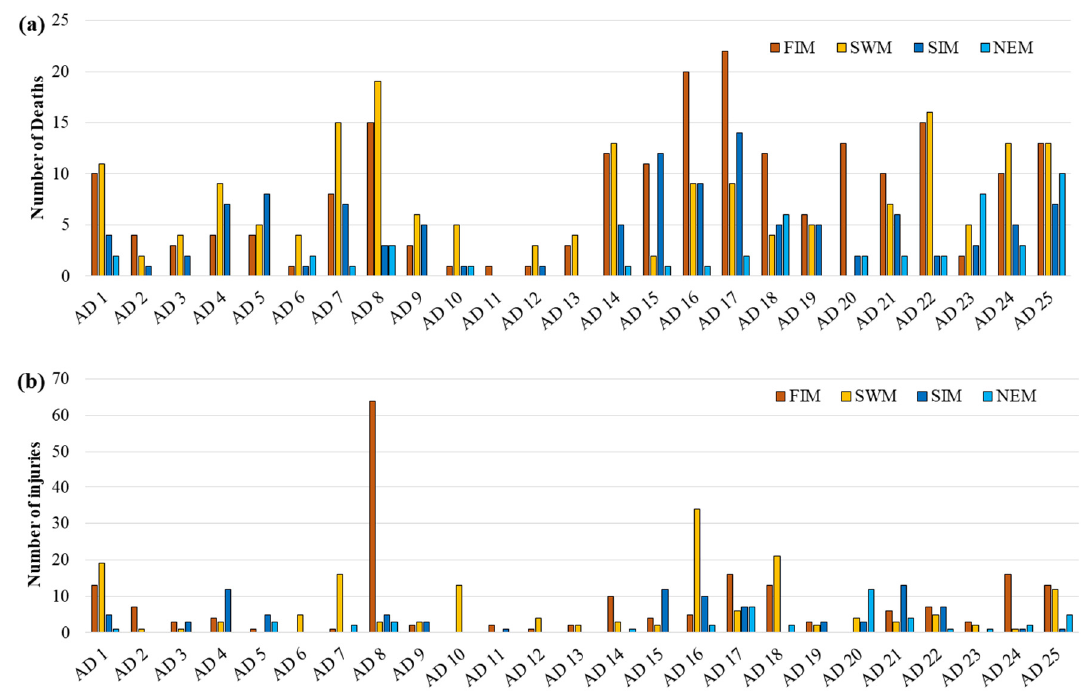
Figure 2. Lightning accidents in Sri Lanka during all four climate seasons, from 1974 to 2019 ( a ) number of deaths; ( b ) number of injuries.